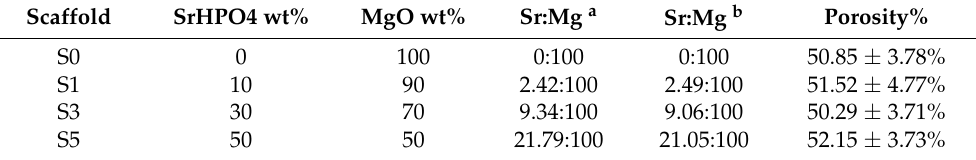
Table 1. The components and porosities of the MgNH 4 PO 4 ·H 2 O/SrHPO 4 composite scaffolds. Scaffold